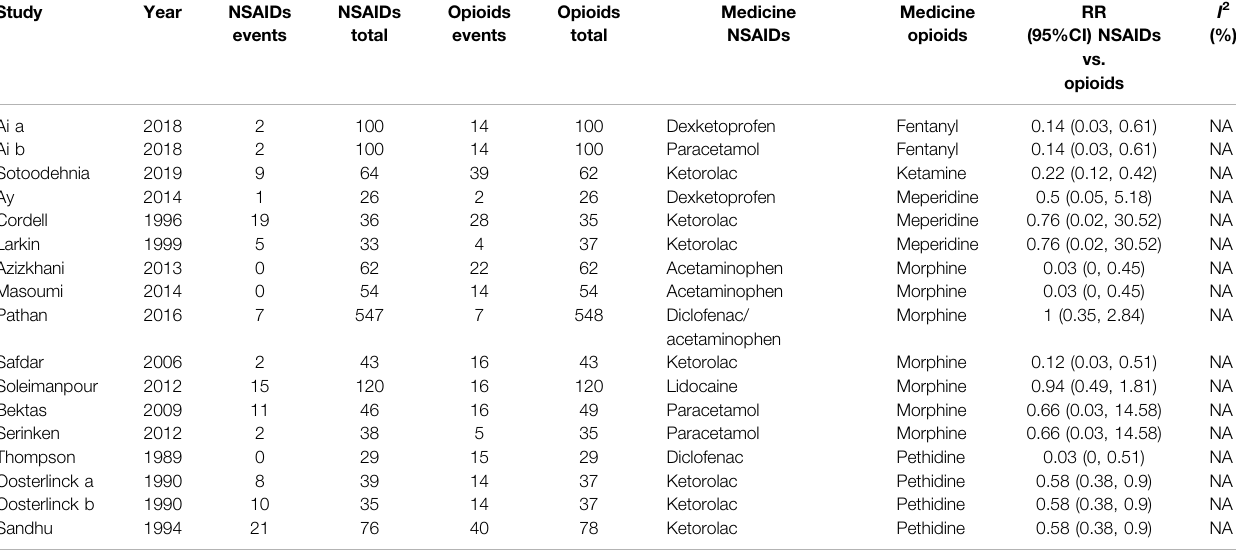
TABLE 6 | Subgroup analysis of NSAIDs and opioids of the drug-related adverse events.